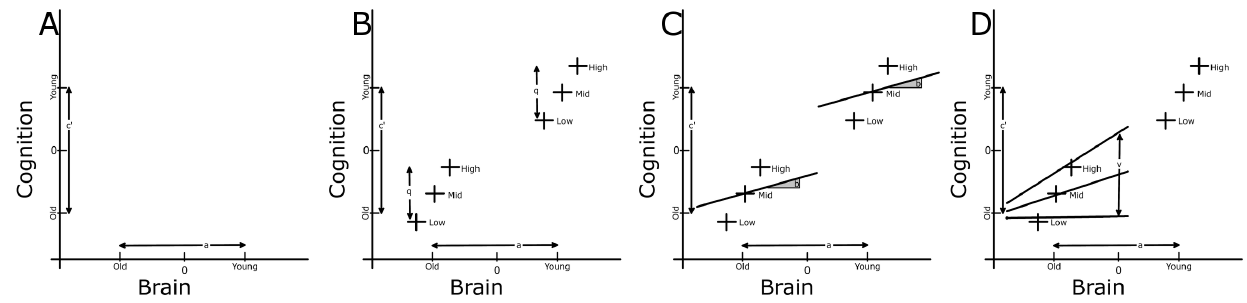
Figure 3. Qualitative illustration of the relationships between brain and cognitive measures for the two age groups at different levels of lifetime exposures. Lifetime exposures was divided into tertiles and referred to as low, medium and high LE. The lines representing the brain-cognition relationships have length equal to the range of values for each tertile of LE. The size of cross hairs on each line is centered at the mean values and has line lengths equal to the standard error. A significant moderation of brain on cognition by LE is evident by a changing slope in the lines as the level of LE changes.